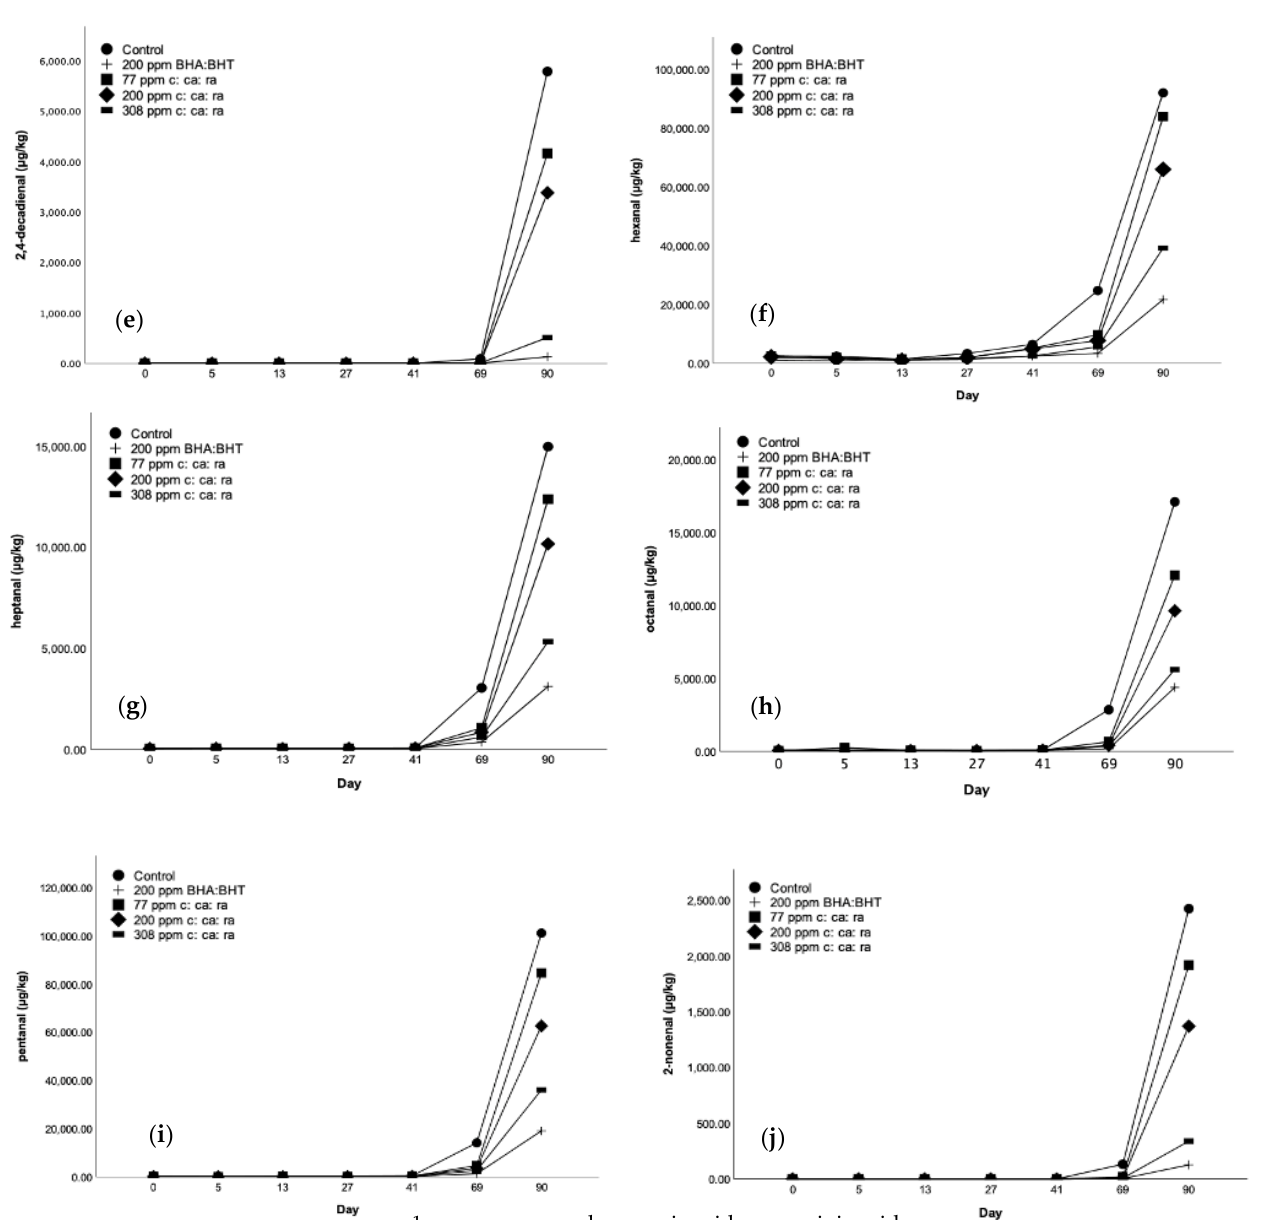
Figure 3. Levels of volatile compounds including ( a ) 2-heptanone, ( b ) 2-pentanone, ( c ) 1-pentanol, ( d ) 3-octane-2-one, ( e ) 2, 4-decadienal, ( f ) hexanal, ( g ) heptanal, ( h ) octanal, ( i ) pentanal and ( j ) 2-nonenal after HS-SPME-GC-MS analysis of FFMPs, before and after accelerated storage (40 °C, RH 23%), with or without the addition of antioxidants. Values are the mean of three replicates ( n = 3) 1 .